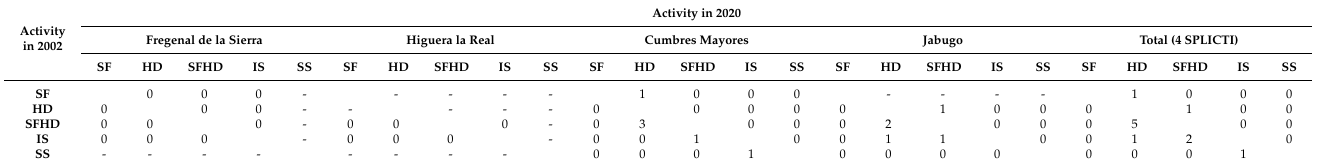
Table 5. Activity changes in 2002 and 2020 in IPTI in the 4